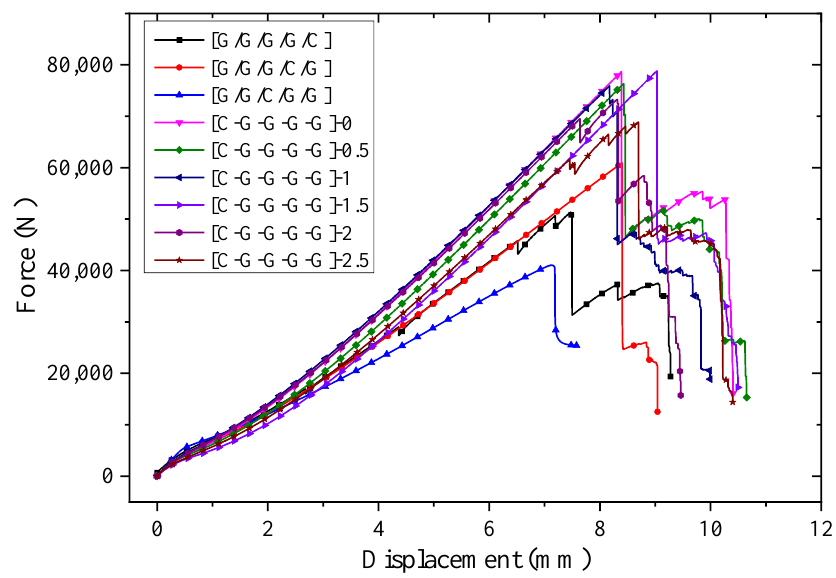
Figure 12. Tensile force–displacement curves of interlayer and intralayer composites with the hybrid ratio C:G = 1:4.